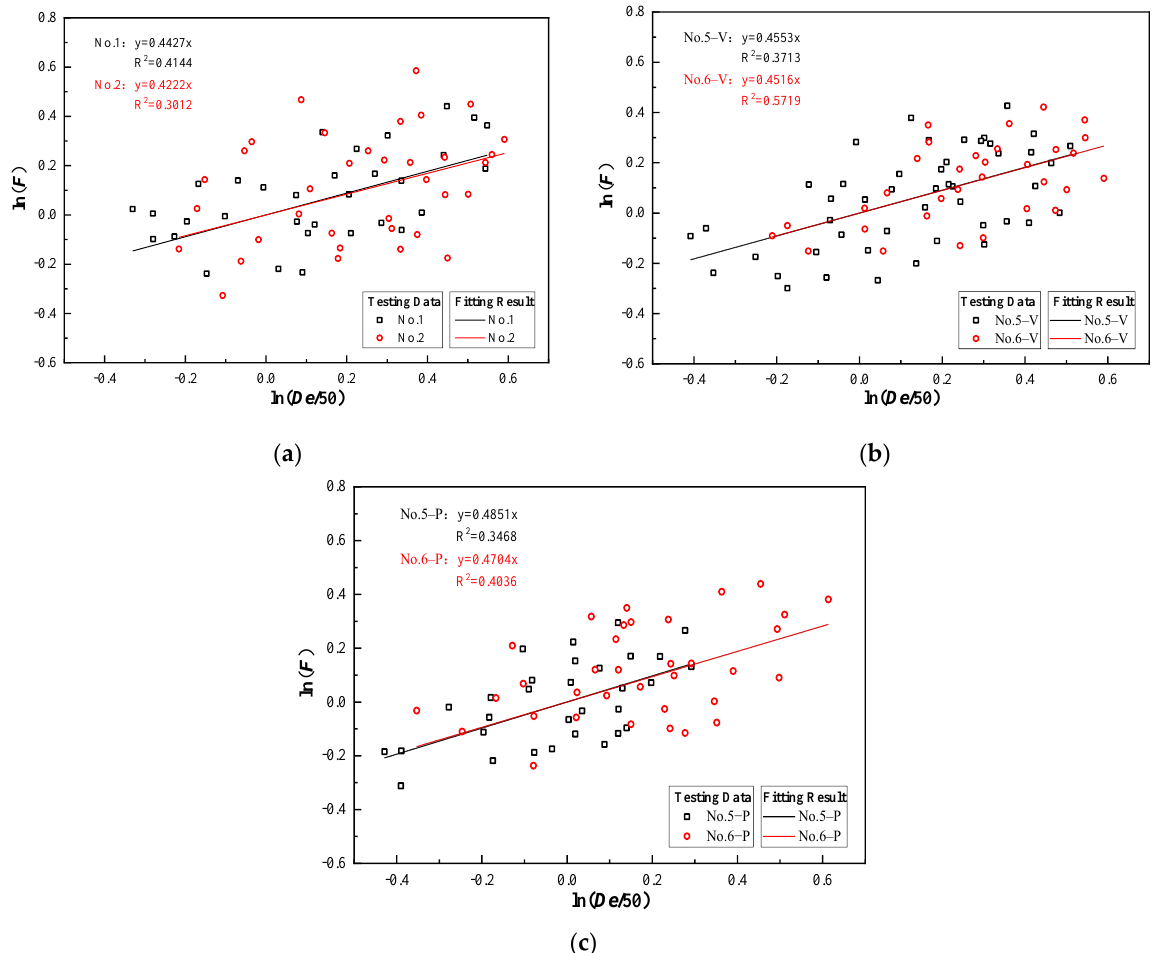
Figure 6. Example of fitting relation curve of ln( F )-ln( D e /50): ( a ) Lump structure; ( b ) layer structure loaded perpendicular to the lamina plane; ( c ) layer structure loaded parallel to the lamina plane.